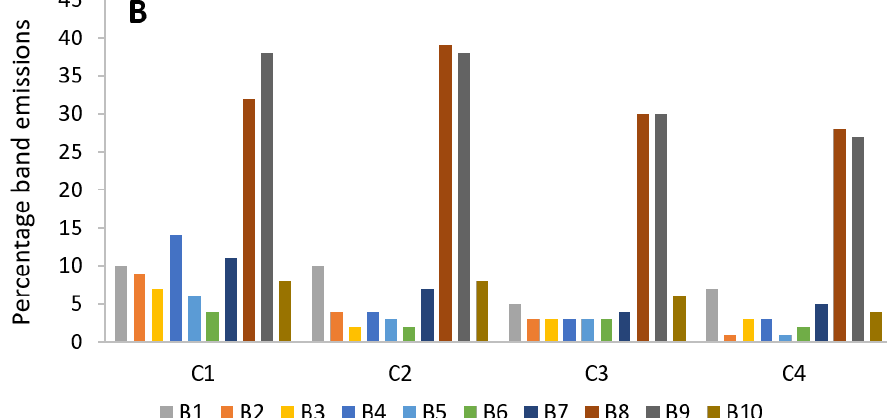
Figure 7. ( A ) Variation of average of BE (counts s − 1 ) measured over a period of 10 cycles. ( B ) Percentage band emissions (PBE) [Equation (2)] obtained relative to ITE for four cycles after mechanical injury.